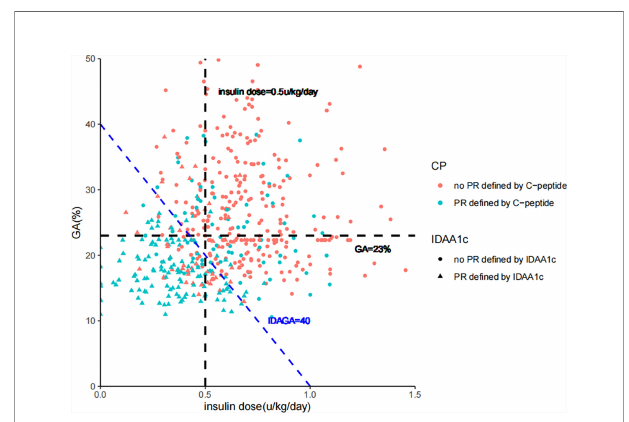
FIGURE 4 | The consistency between diagnosis of partial remission de fi ned by IDAGA ≤ 40; IDAA1C ≤ 9; GA ≤ 23%/insulin dose ≤ 0.5 u/kg/day; and